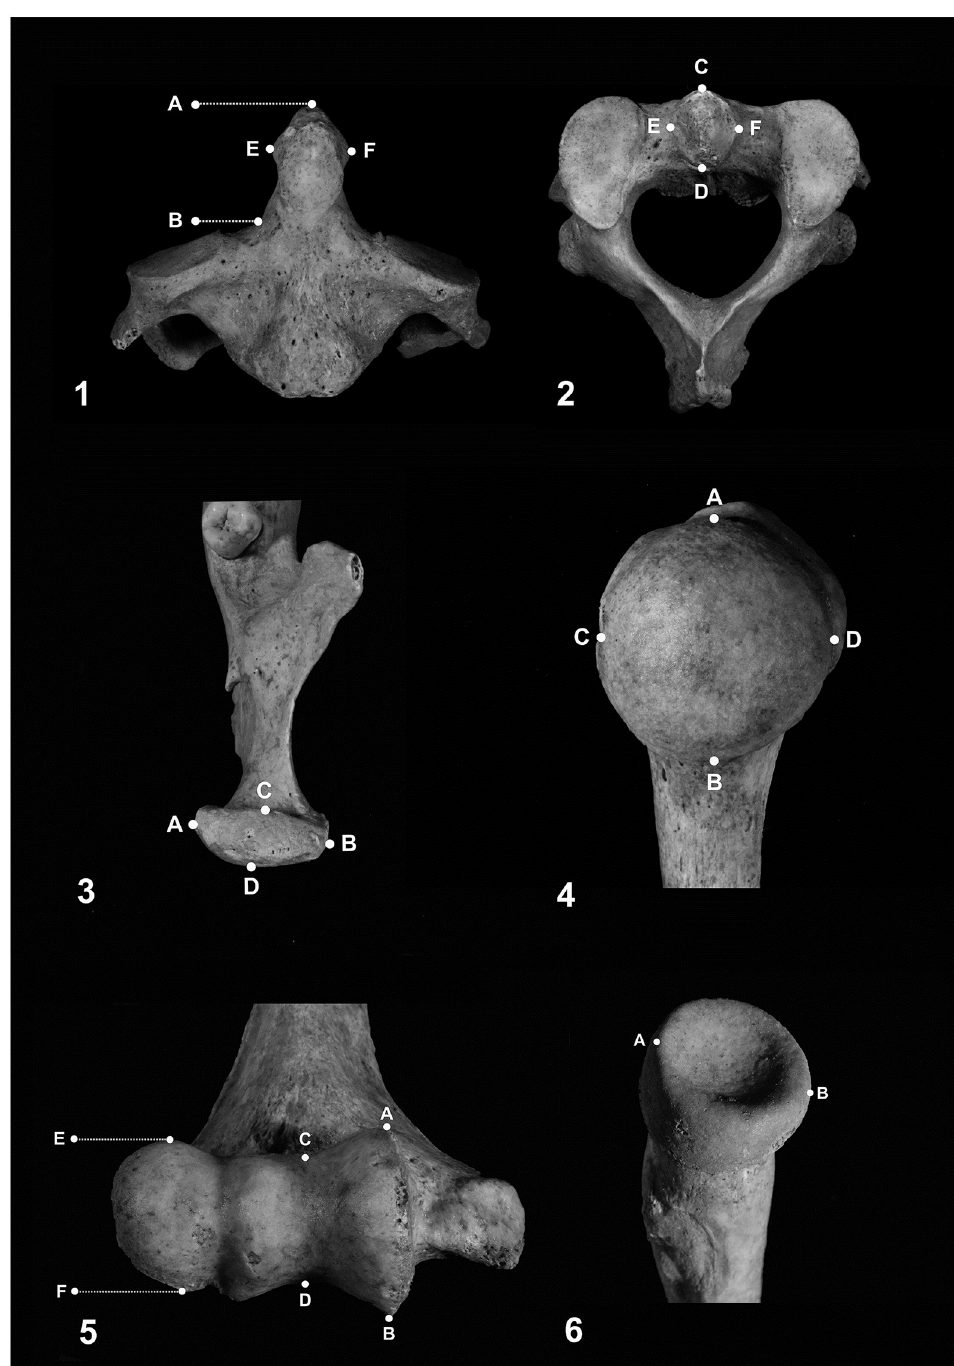
Fig 3. Schematic illustration of 11 measurements used in the study. 1 & 2) Axis: A-B = dens height; C-D = dens anteroposterior diameter; E-F = dens transverse diameter. 3) Mandible: A-B = condyle width; C-D = condyle thickness. 4) Humerus head: A-B = vertical diameter; C-D = transverse diameter. 5) Humerus distal epiphysis: A-B = trochlea maximum diameter; C-D = trochlea minimum diameter; E-F = capitulum maximum diameter. 6) Radius: A-B = head maximum